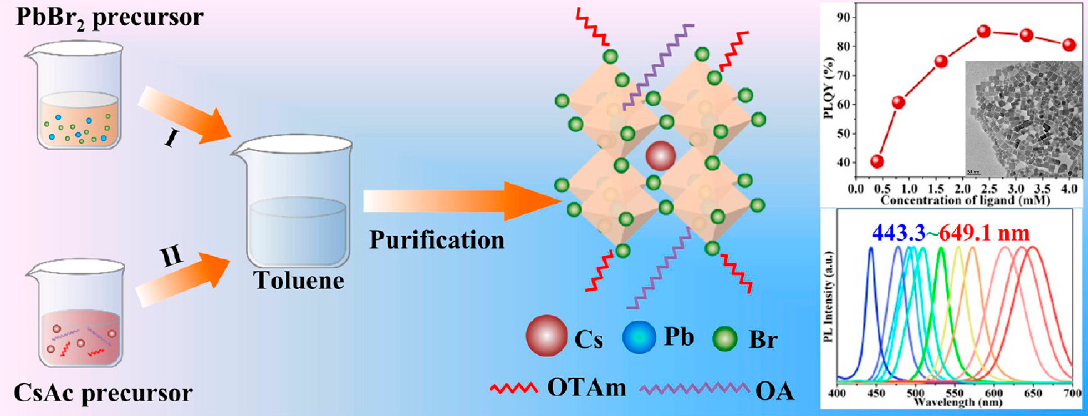
Figure 2. Synthesis of Colloidal CsPbBr 3 PeNCs via LARP method (Graphical abstract) [42]. © Elsevier.